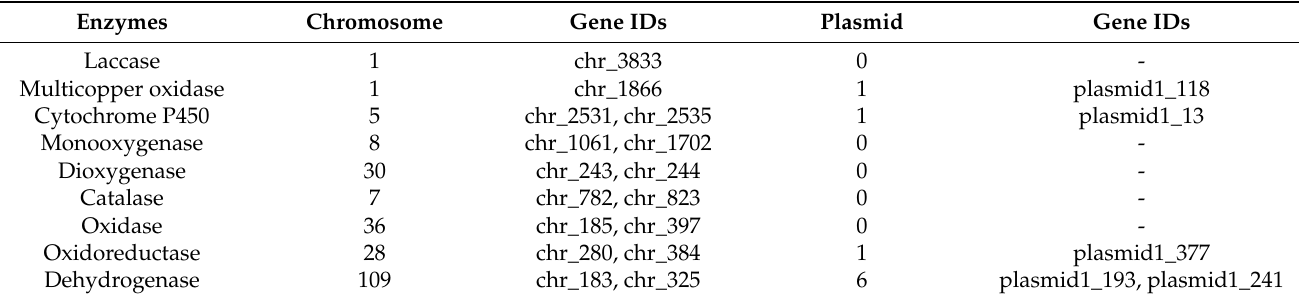
Table 2. Enzymes that related to lignin degrading in functional annotation of eggNOG.